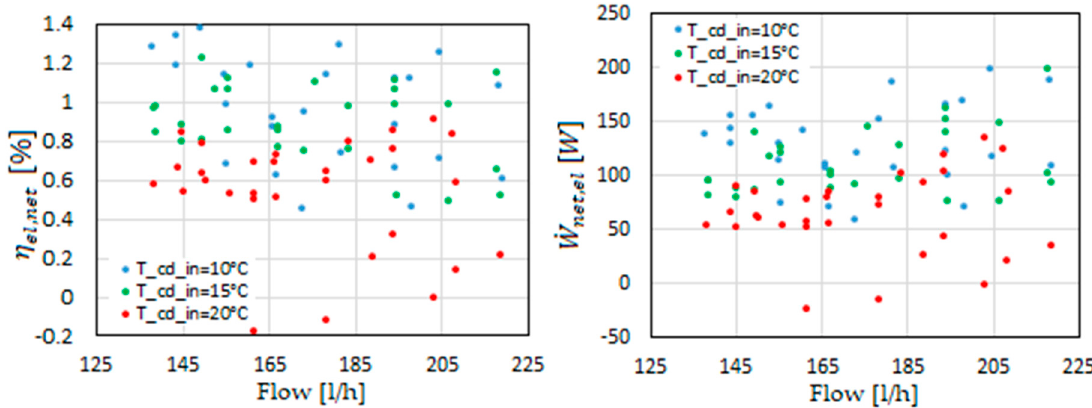
Figure 9. ORC system net electric efficiency ( left ), and net electric power with flow rate ( right ).